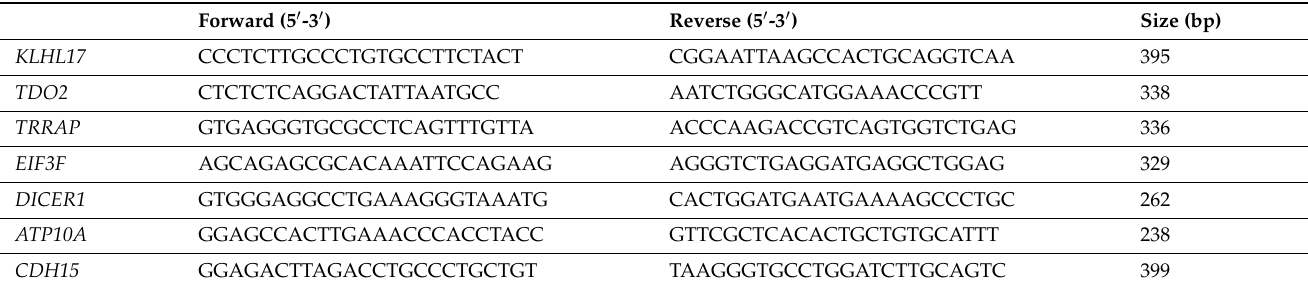
Table 2. Primer sequences, optimal annealing temperature (Ta, ◦ C), and size of PCR products for the verification of the mutations identified in this study using Sanger